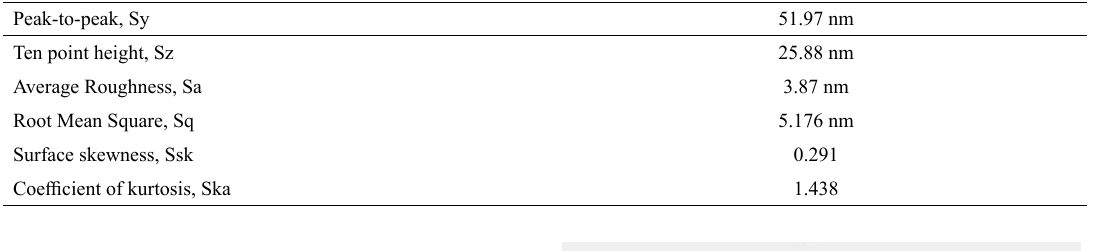
Table 3. Roughness analysis of MMTG crystal